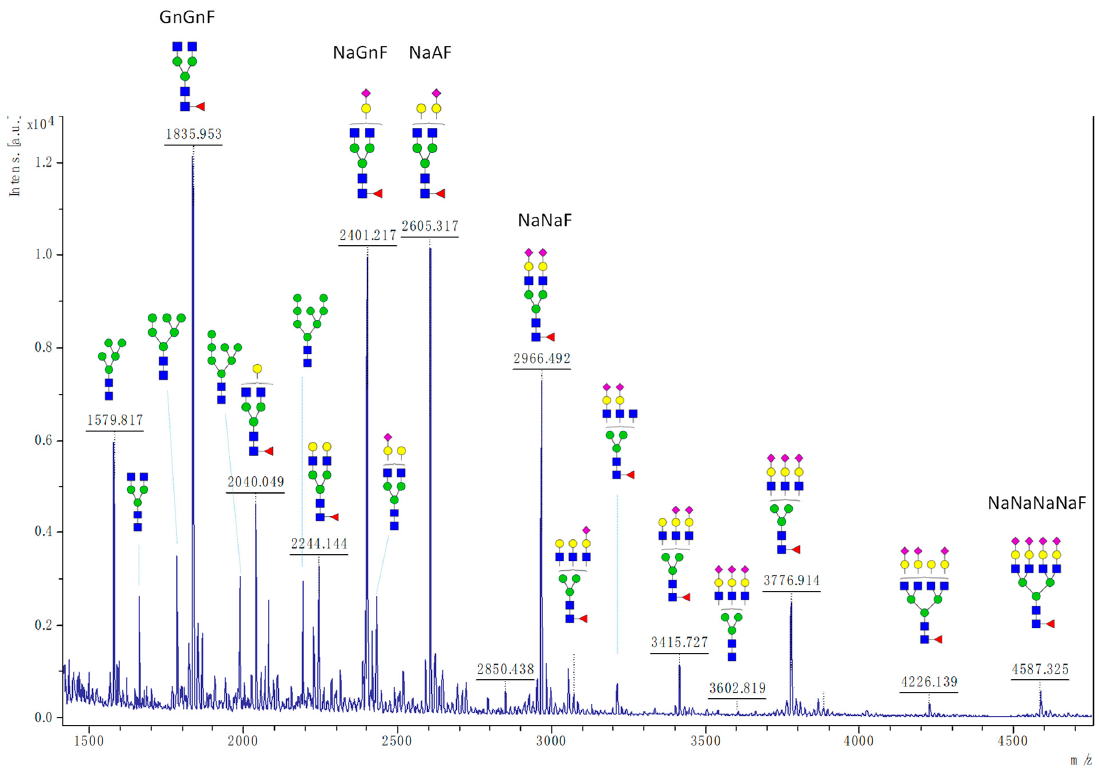
Figure 3. Global N-glycan repertoire of gB ectodomain produced in CHO cells. Glycans are annotated with cartoons above main peaks as recommended [34] .